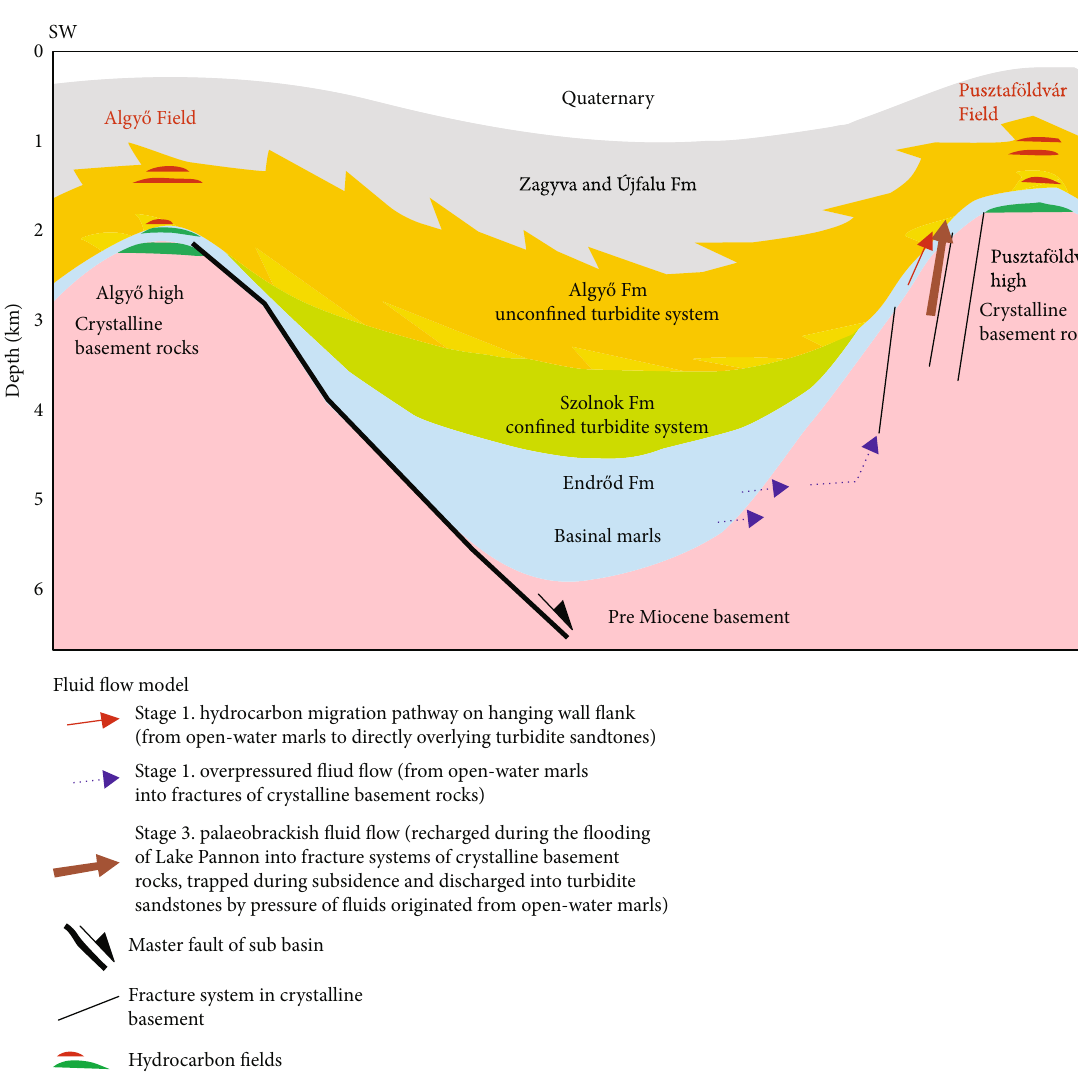
Figure 17: Reconstruction of fl uid fl ows for the studied northeastern segment of the Makó Trough, which is located at the passive margin setting near the Pusztaföldvár High. This model is adapted and modi fi ed after Juhász et al. [109], which was previously proposed for a neighboring subbasin (Békés Basin). The schematic section is based on seismic pro fi le (data compiled from Bada et al. [23] and Molnár et al. [110]). Sandy turbidite lobes are marked in yellow at the lower part of the Algy ő Fm. Blue arrows indicate hydrologic connection between the basinal deposits and the fractured basement rocks. The thick brown arrow indicates the origin of sulphate-rich extraformational fl uid, which was responsible for creating the open porosity in sandstones in the deep burial realm. Red arrows indicate the kerogen migration — according to the model by Szalay and Koncz [47], Magyar et al. [48], and Bada et al. [22] — from which the organic matter was preserved as streaks of residual bitumen in the upper turbidites (Algy ő